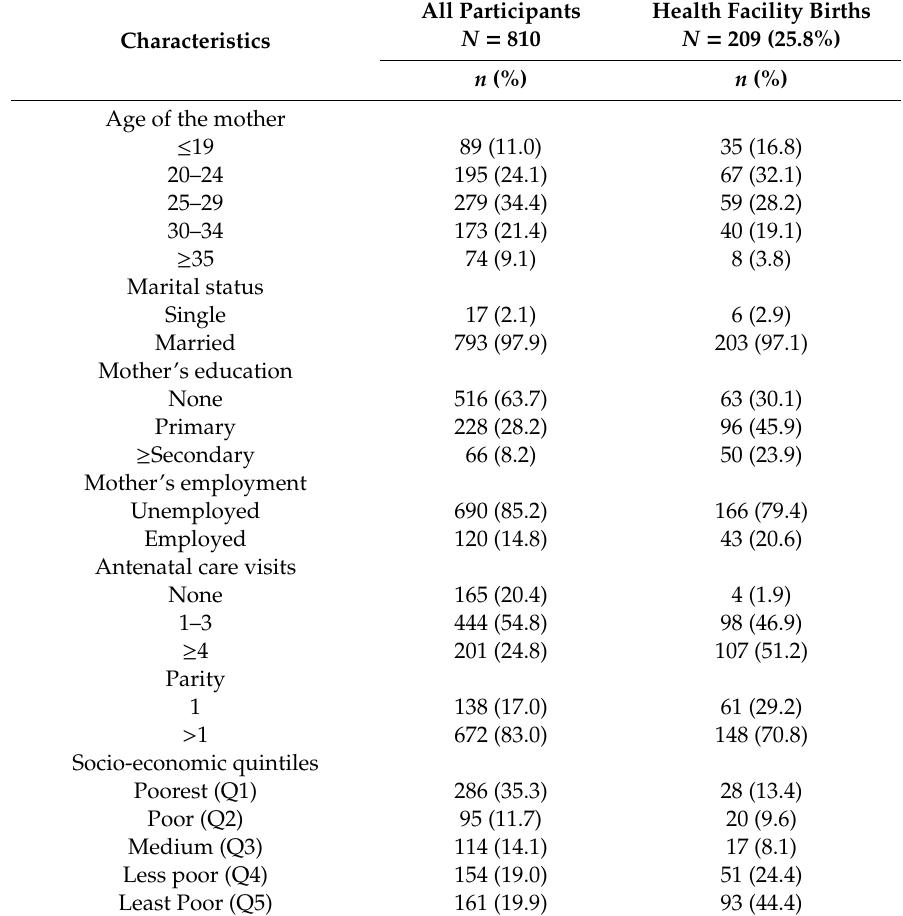
Table 1. Baseline characteristics of mothers in a community survey in Jubek State, South Sudan.